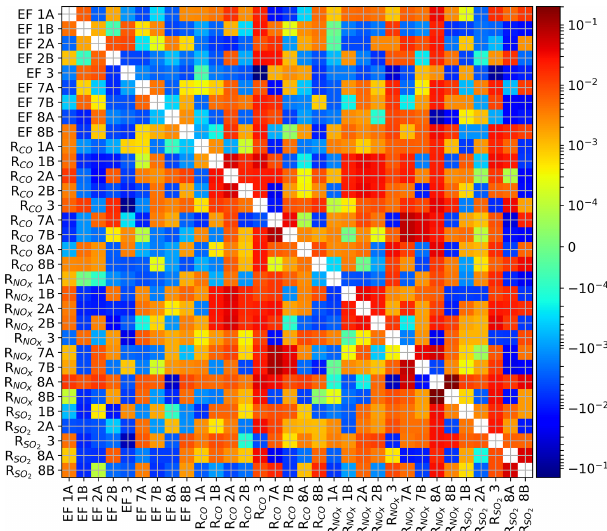
Figure D1. Matrix showing the difference in correlation coeffi- cient ( r ) between the CO 2 _only_no_propagation and No_ prop- agation run averaged for all 14d, where positive differences in- dicate reduced parameter correlations when all tracers are in- cluded (No_propagation). (Sub-)sectors are indicated with their short names as summarized in Table 1. For some parameters, a strong reduction in parameter correlations is shown, indicating that with all tracers that parameter can be more easily separated from others, e.g. the emission factors of industry and coal-fired power plants (EF3 and